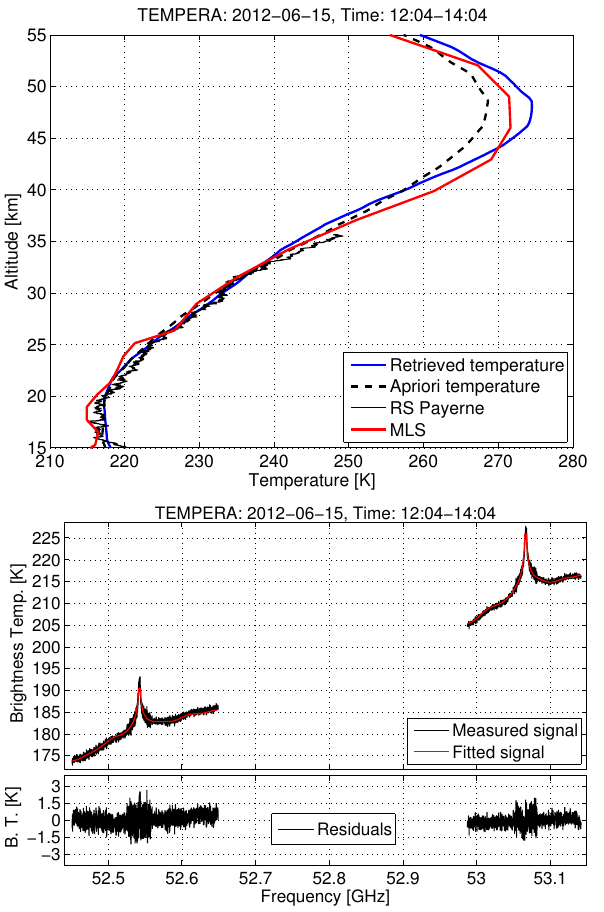
Fig. 14. Measurement of 15 June 2012 from 12:04–14:04 (UT) dur- ing clear sky (ILW=0mm). Upper panel: temperature profile (blue Fig. 14. Measurement of June 15, 2012 from 12h04-14h04 (UT) during clear sky (ILW=0 mm). Up- line) retrieved with TEMPERA spectrometer measurements. The Fig. 15. Measurement of 15 June 2012 from 12:04–14:04 (UT) dur- a priori profile is the dashed black line. The retrieved profile is com- per panel: Temperature profile (blue line) retrieved with TEMPERA spectrometer measurements. The ing clear sky (ILW=0mm). Upper panel: The averaging kernels pared with radiosonde data from Payerne (black line) and with MLS Fig. 15. Measurement of June 15, 2012 from 12h04-14h04 (UT) during clear sky (ILW=0 mm). Upper (AVK, plotted every 7th) of TEMPERA are shown in this plot to- data (red). Lower panel: Brightness temperatures measured with a-priori profile is the dashed black line. The retrieved profile is compared with radiosonde data from gether with the measurements response (MR) and the full-width at TEMPERA (black) compared with the forward model brightness panel: The averaging kernels (AVK, plotted every 7th) of TEMPERA are shown in this plot together with half-maximum (FWHM, in km). Lower panel: error of the retrieval. Payerne (black line) and with MLS data (red). Lower panel: Brightness temperatures measured with temperatures (red) that we received with the retrieval. Low in the The error statistics contain the total error (solid red) consisting of panel the residuals are seen. In the forward model ± 1MHz around the measurements response (MR) and the full-width at half-maximum (FWHM, in km). Lower panel: TEMPERA (black) compared with the forward model brightness temperatures (red) that we received with observation error (solid blue) and smoothing error (solid black). The the two line centers we have no frequencies points in the grid be- total systematic error (dotted black) contains the uncertainties in the Error of the retrieval. The error statistics contain the total error (solid red) consisting of observation error cause until now the Zeeman effect has not been incorporated into the retrieval. Below the residuals are seen. In the forward model ± 1 MHz around the two line centers calibration (dashed blue), in the oxygen profile (“spectroscopic er- Qpack2/ARTS2. In the center of the lines ( ± 16MHz, 1000 chan- (solid blue) and smoothing error (solid black). The total systematic error (dotted black) contains the ror”, dashed red) and in the water vapor profile (dashed black). nels) we use all channels and on the wings of the line we use a we have no frequencies points in the grid, because until now the Zeeman effect has not been incorporated binning of 3 channels for data reduction. uncertainties in the calibration (dashed blue), in the oxygen profile (”spectroscopic error”, dashed red) in Qpack2/ARTS2. In the center of the lines ( ± 16 MHz, 1000 channels) we use all channels and on the and in the water vapor profile (dashed black). wings of the line we use a binning of 3 channels for data reduction. seen. The results show that the intensity of the emission lines is highest at za = 30 ◦ . Therefore we decided to measure the emission lines at this 34